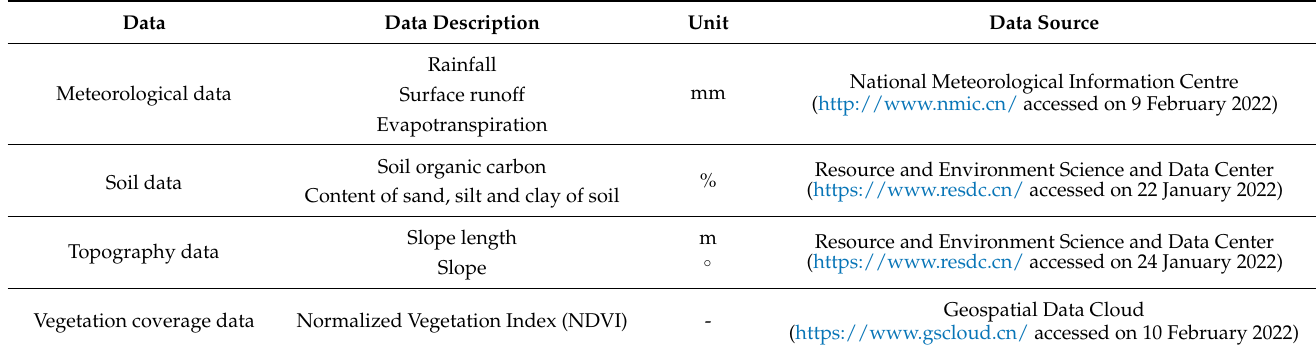
Table 1. The description and resource of the study